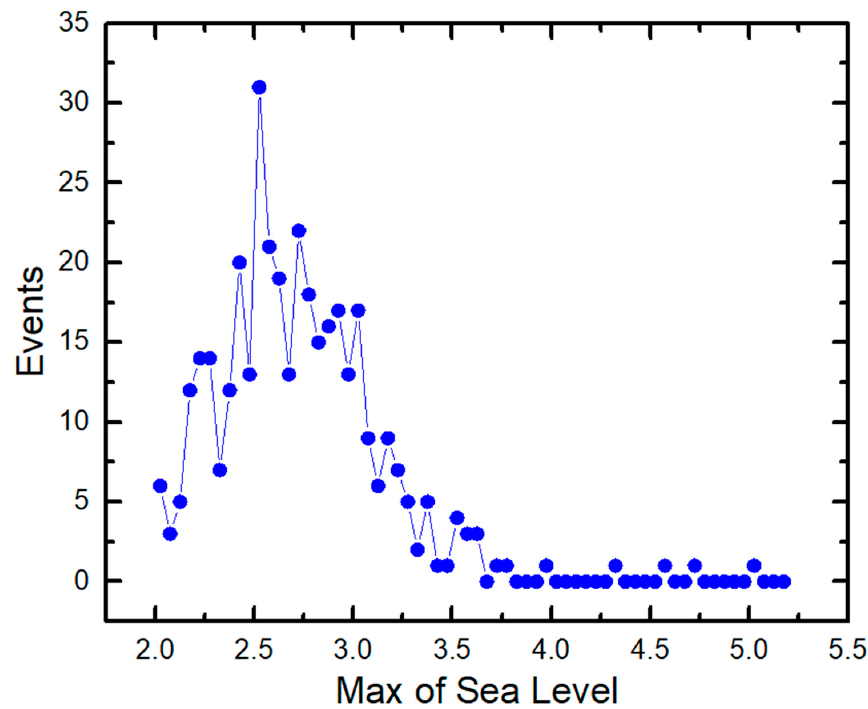
Figure A4. Historical ESL events.